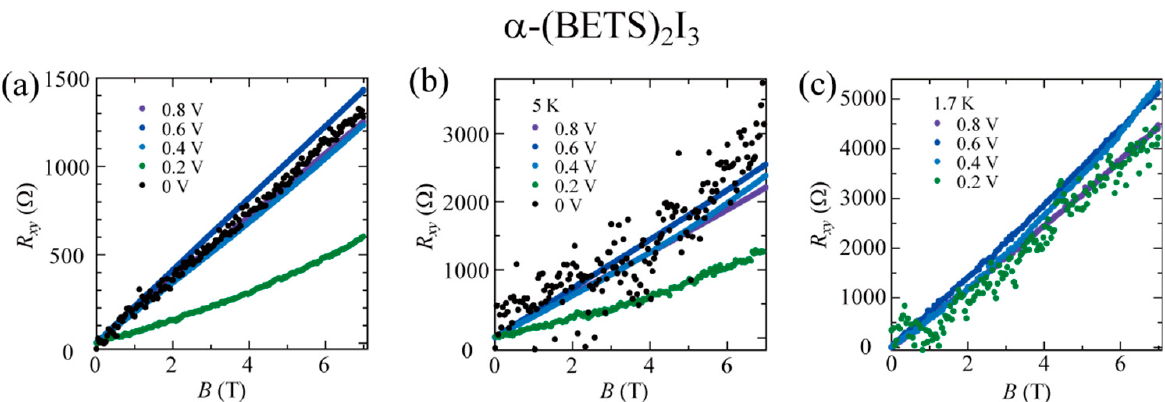
Figure 7. Magnetic field dependence of the Hall resistance under electron doping at ( a ) 10, ( b ) 5, and ( c ) 1.7 K.